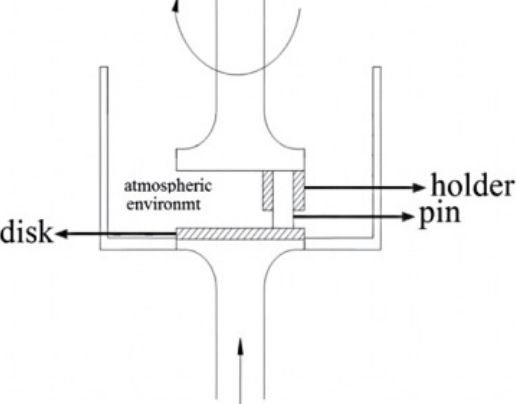
Figure 3. Schematic diagram of pin-disc friction and wear tester. Reprinted with permission from Ref. [11]. 2019, IOP Publishing Ltd.